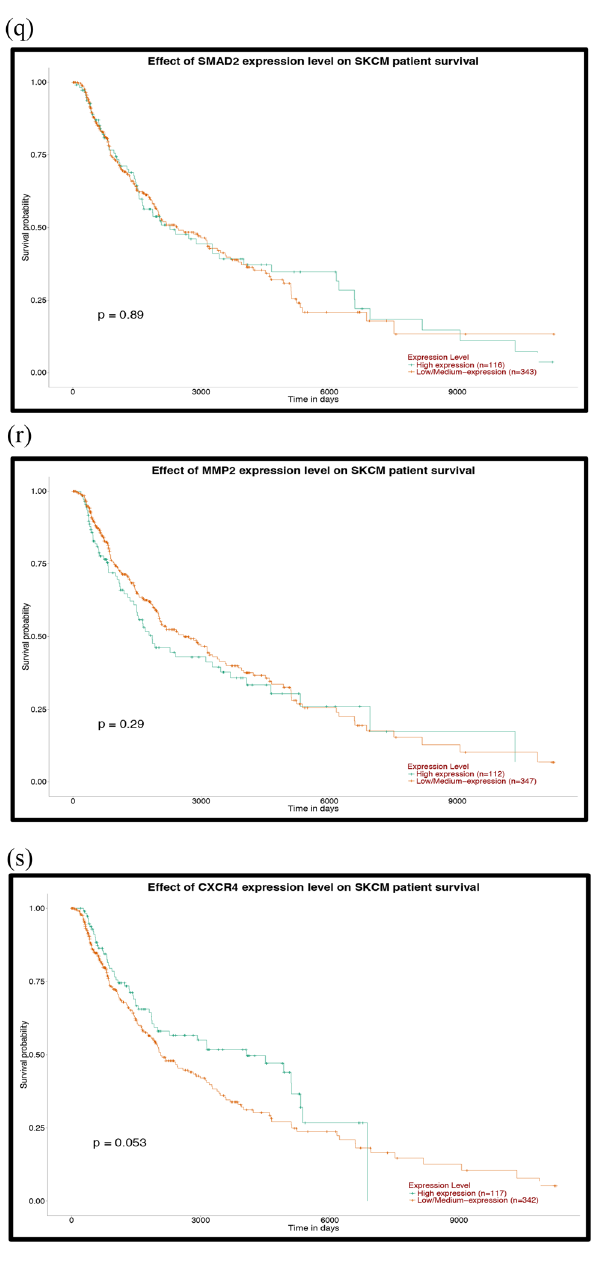
Figure 7: Prognostic analysis of the hub genes of the upregulated miRNAs with the UALCAN database: ( a ) VEGFA, ( b ) PIK3R1, ( c ) HSPA4, ( d ) ABL1, ( e ) CHEK1, ( f ) CDK2, ( g ) IGF1R, ( h ) POLR2F, ( i ) CBL, ( j ) BTRC and ( k ) YWHAE. P < 0.05 was considered statistically signi fi